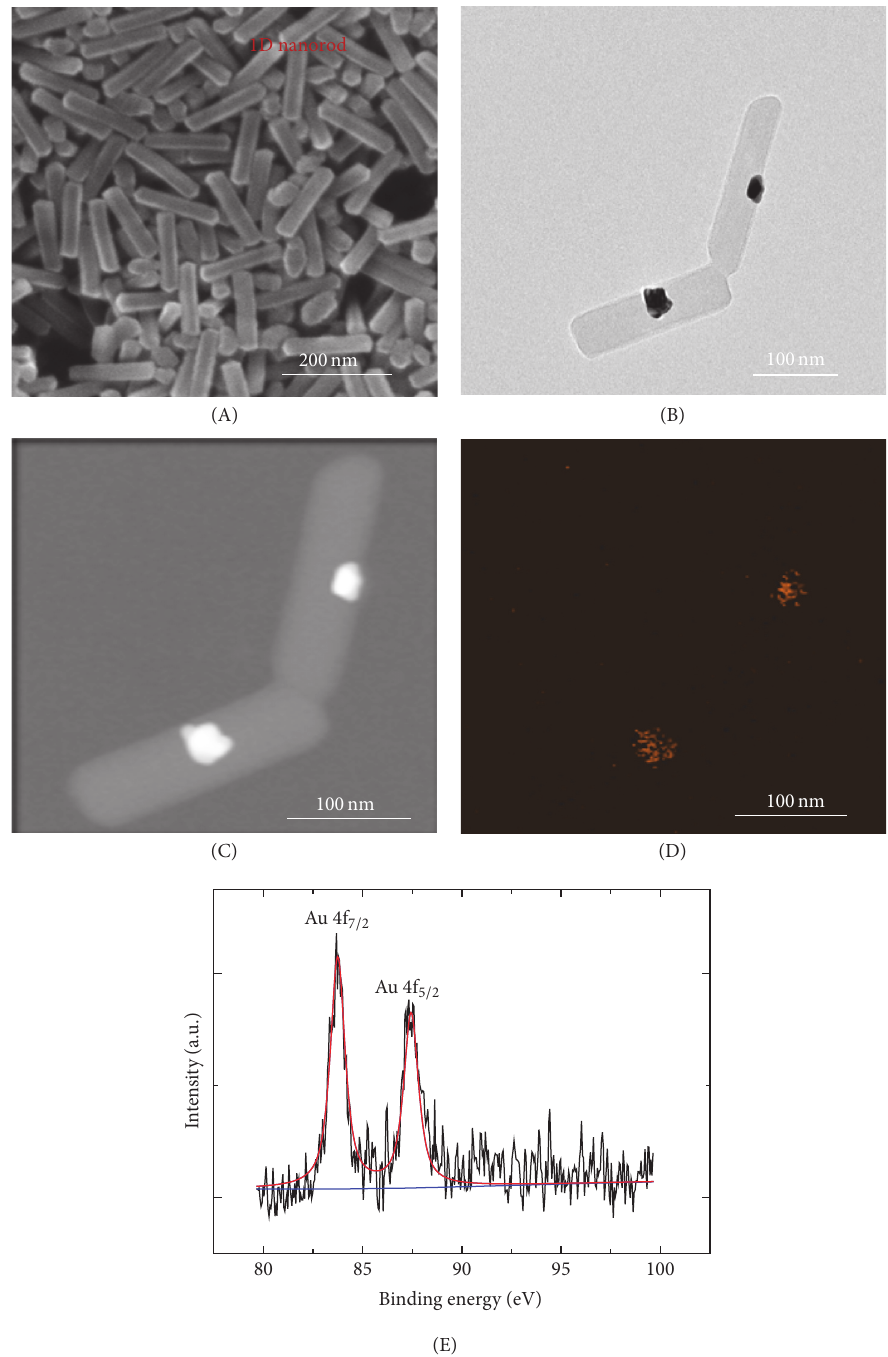
Figure 1: (A) SEM image of the Z-CPPs nanorod structures; TEM (B) and STEM (C) images of Au-Z-CPPs; elemental mapping data of (C) Au on ZnTPyP-CPPs; (E) XPS analysis of Au element for